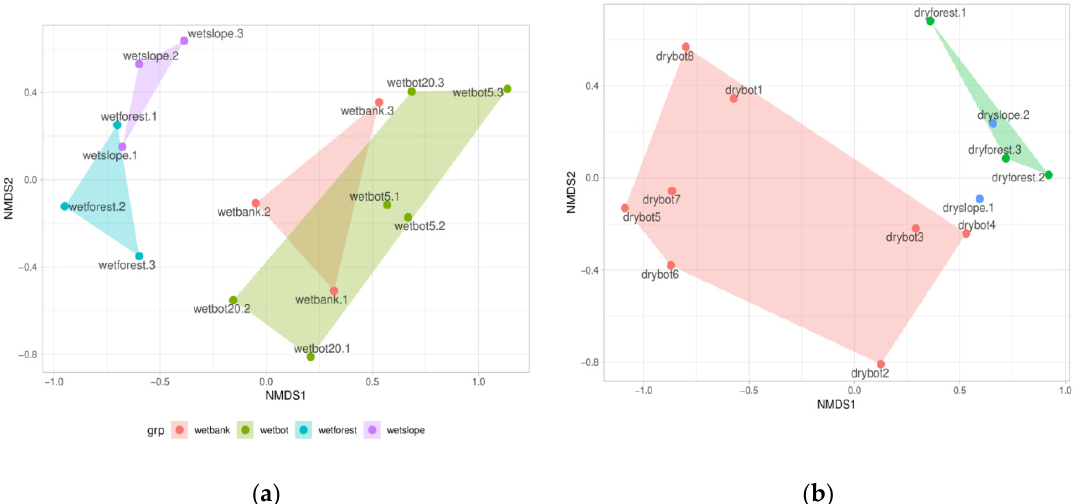
Figure 3. Non-metric multidimensional scaling plot of sampling sites of the forested ravine: ( a ) in the two-year humid period (stress R 2 = 0.119, goodness-of-fit: nonmetric 0.986, linear R 2 = 0.916); ( b ) in the two-year drought period (stress 0.096, goodness-of-fit: nonmetric R 2 = 0.991, linear R 2 = 0.953). Data were Hellinger transformed, and Kulczynski distances were used. Convex hulls show habitats. The names of the sites consist of three parts: first, “wet” or “dry” indicates the climatic conditions; the second part regards the habitat: “bot”—bottom of the ravine, “bank”—banks of the streams, “slope”—slope of the ravine, and “forest”—forest; and the third is a number indicating the sampling site.